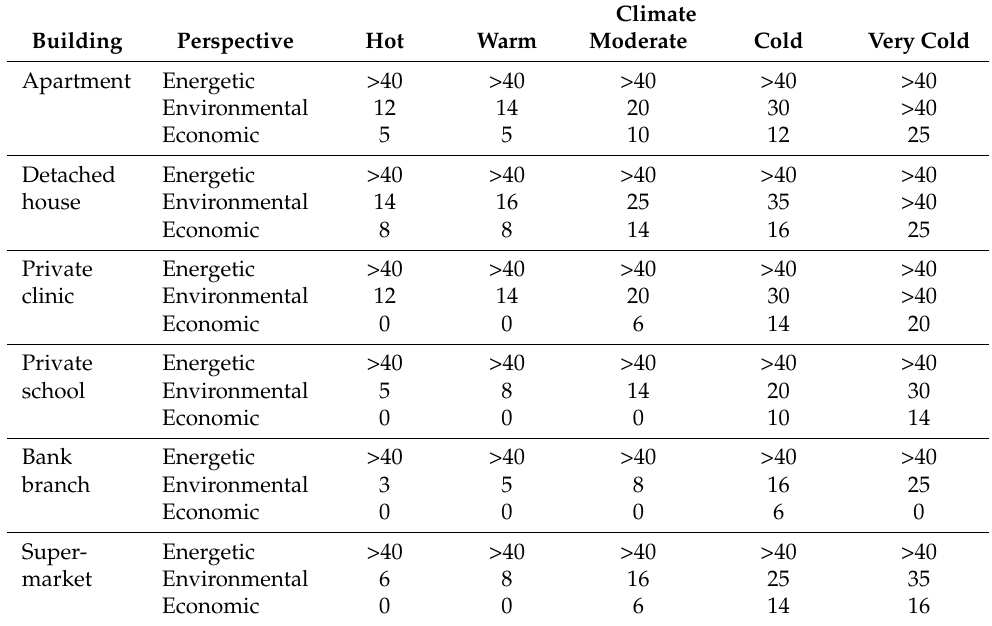
Table 7. Optimal EPS thickness [cm] from energy, environmental, and economic